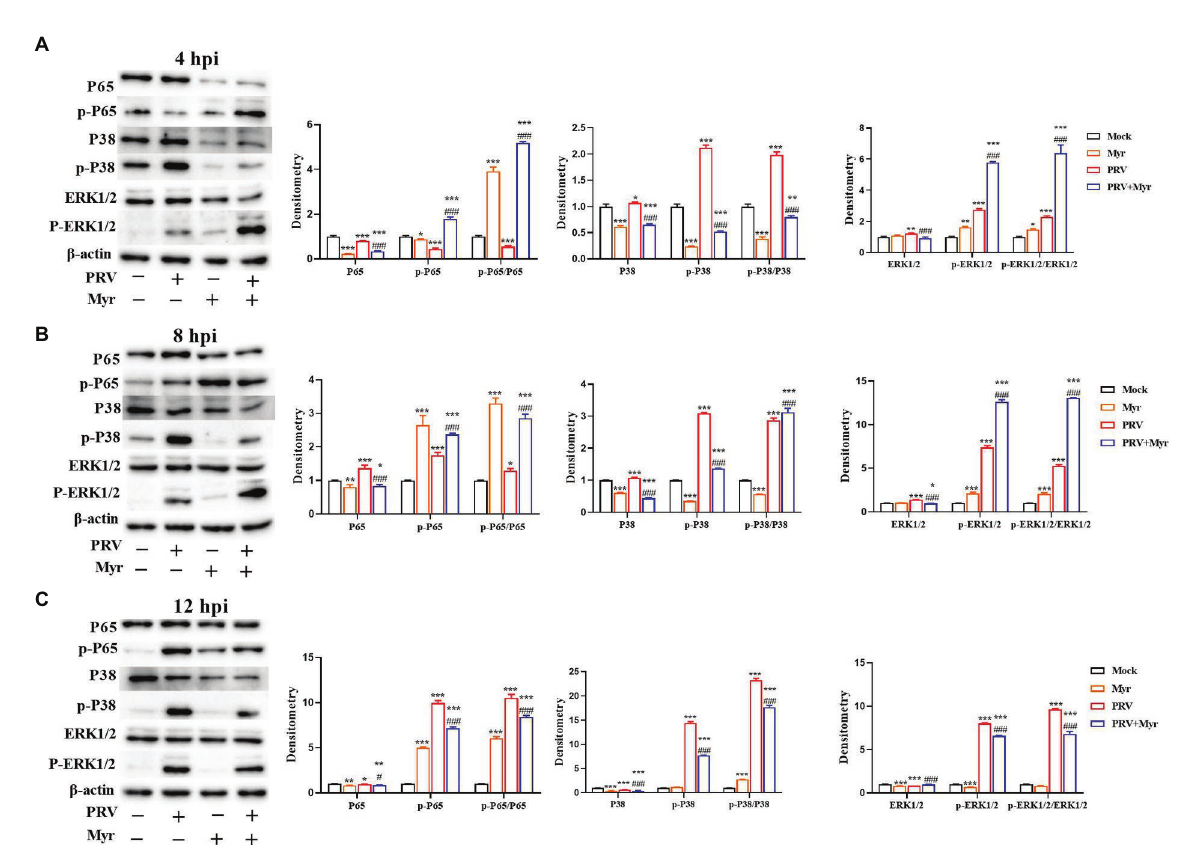
FIGURE 5 The changes of the NF- κ B and MAPK pathways. The PK-15 cells were infected with or without PRV (MOI = 1) in the presence or absence of myricetin. Expressions of P65, p-P65, ERK1/2, p-ERK1/2, P38, and p-P38 were determined by Western blotting at 4 (A) , 8 (B) , and 12 (C) hpi. Mock, the uninfected-untreated cells; Myr, the uninfected group with myricetin treatment. PRV, the infected group without treatment; PRV + Myr, the infected group with myricetin treatment. Data are presented as mean ± SD, n = 6. Symbols “*, **, and ***” represent p < 0.05, p < 0.01, and p < 0.001, respectively, between the mock group and other groups. Symbols “# and ###” represent p < 0.05 and p < 0.001, respectively, between the PRV group and PRV + Myr